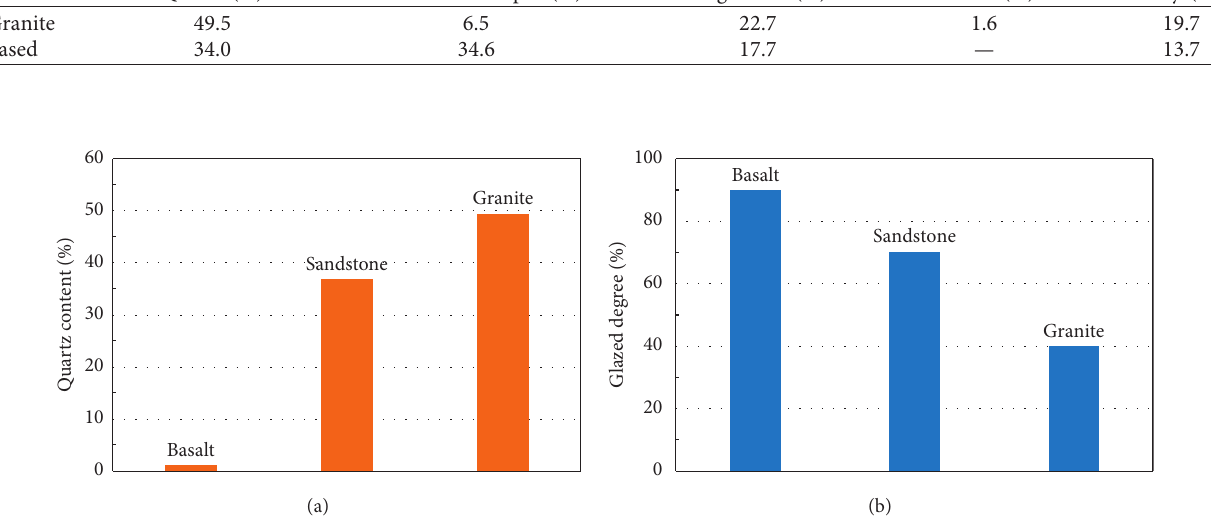
Figure 5: Comparison between quartz content and glazed degree of rock. (a) Quartz content in original rock. (b) Glazed degree of the rock after laser